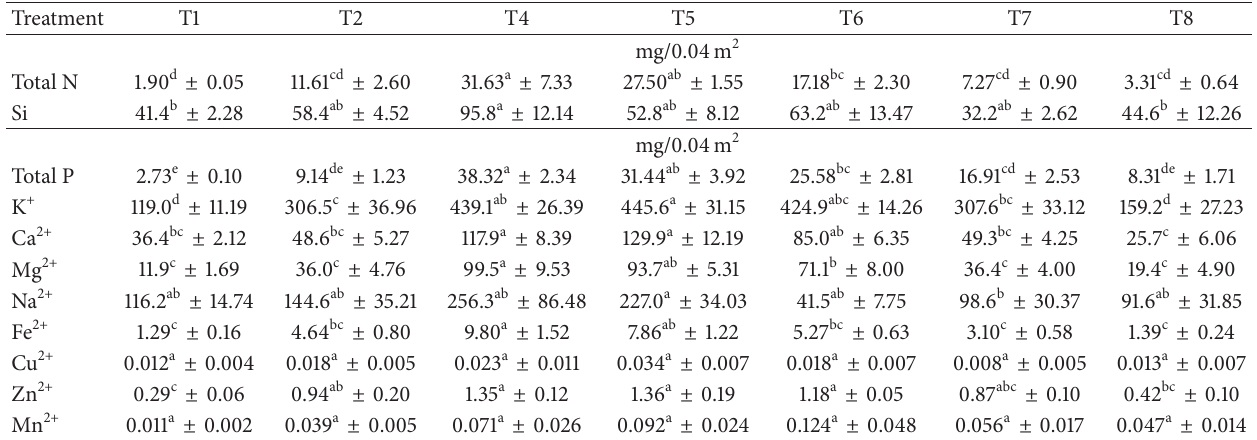
Table 10: Effects of coapplication of biochar and urea on nutrients uptake in a field